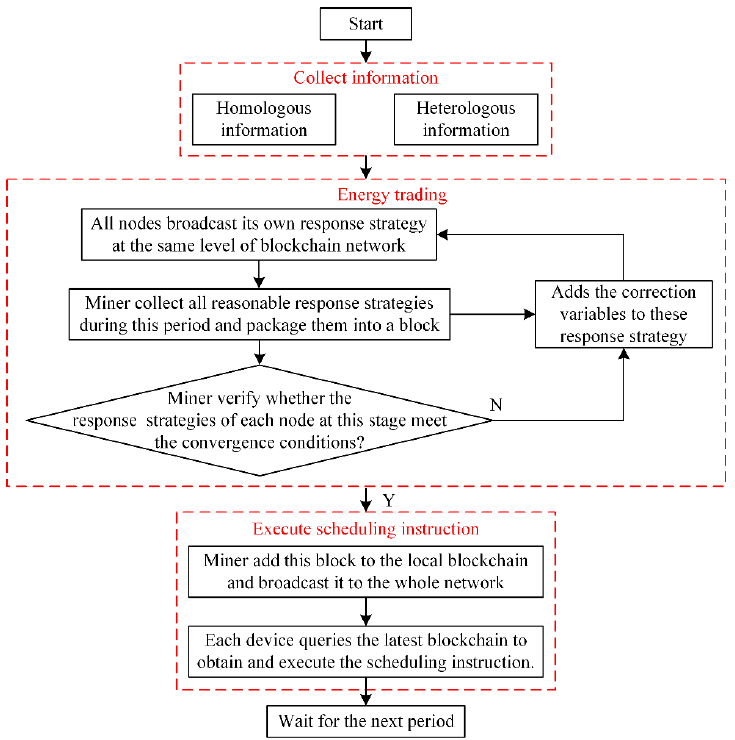
Figure 5. The flowchart of the multilevel and multichain information transmission